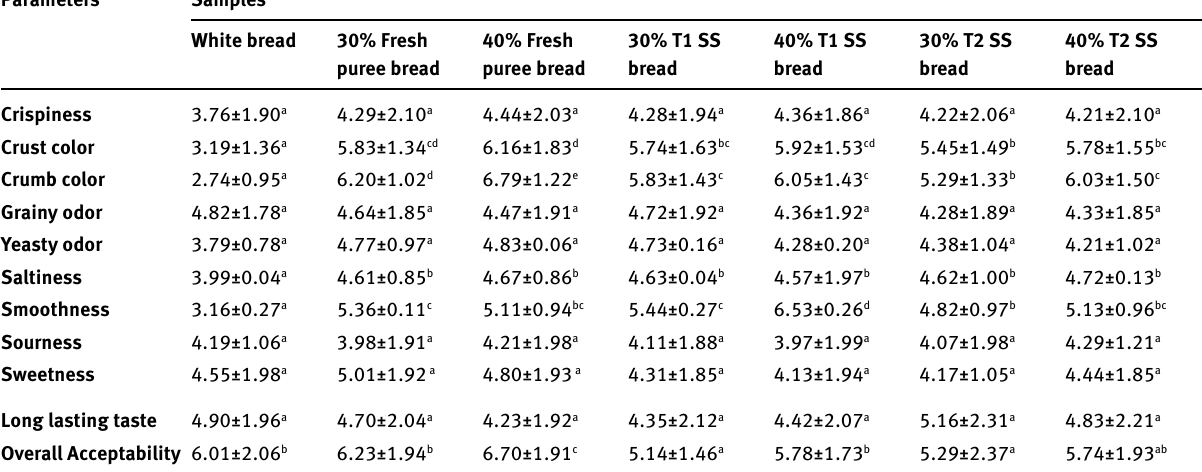
Table 2: Results for descriptive sensory scores of bread samples Parameters